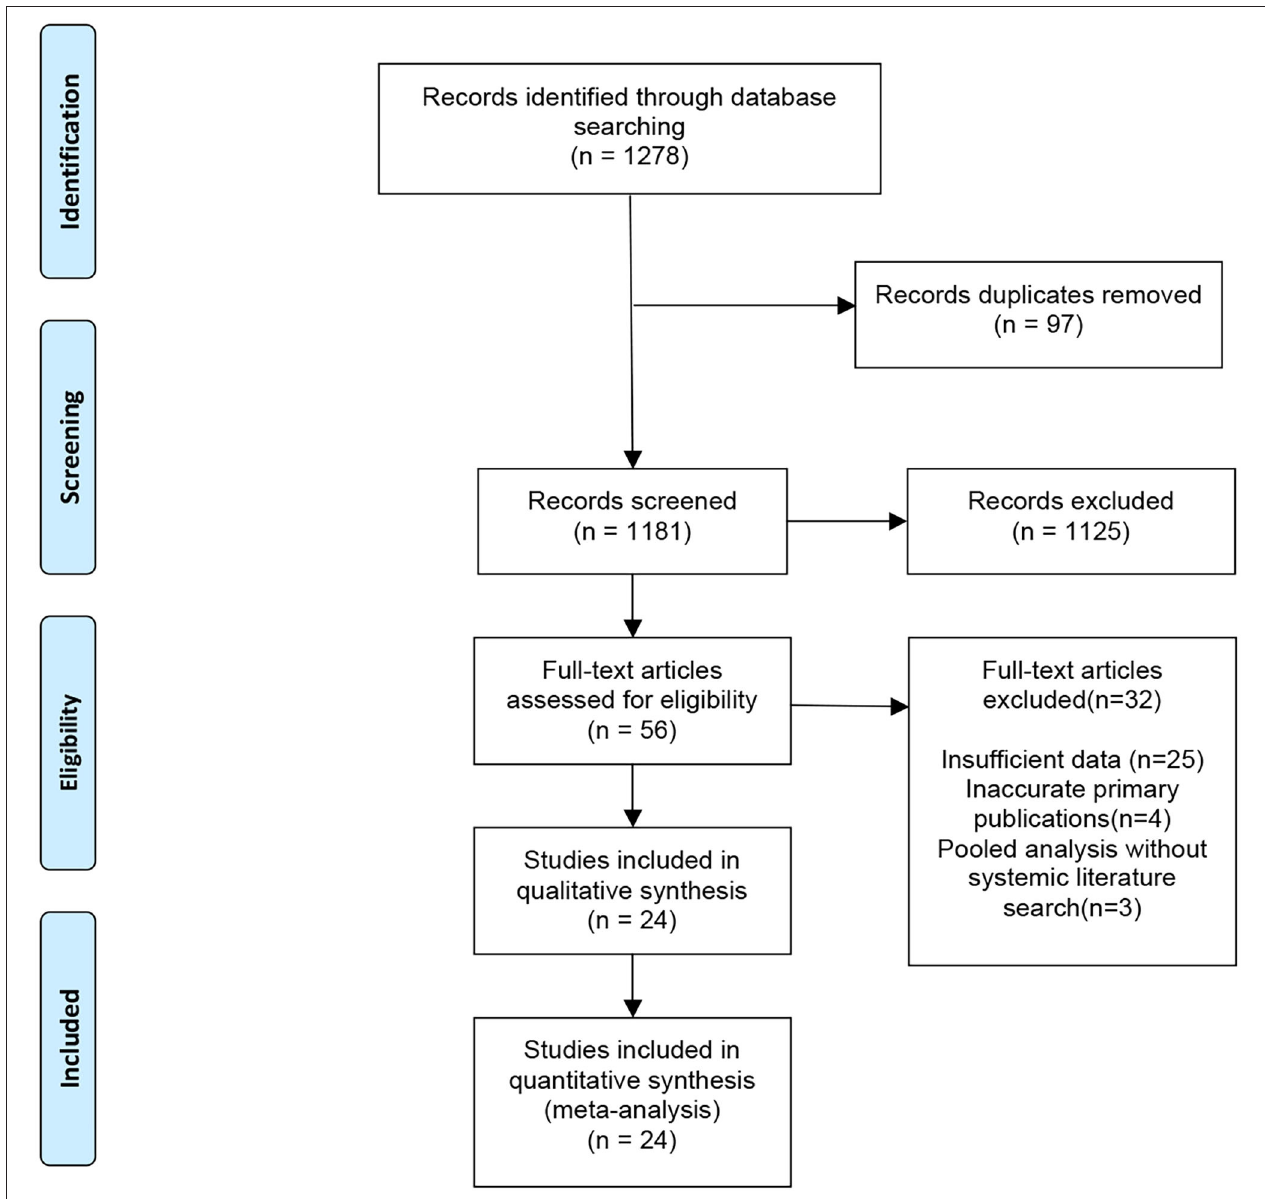
FIGURE 2 | Flowchart of literature